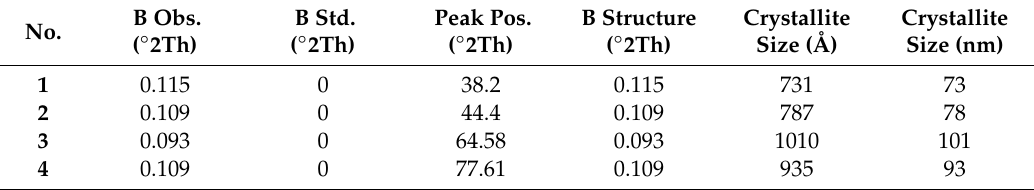
Table 2. Structure parameters of the taurine-capped AuNPs with λ max 545